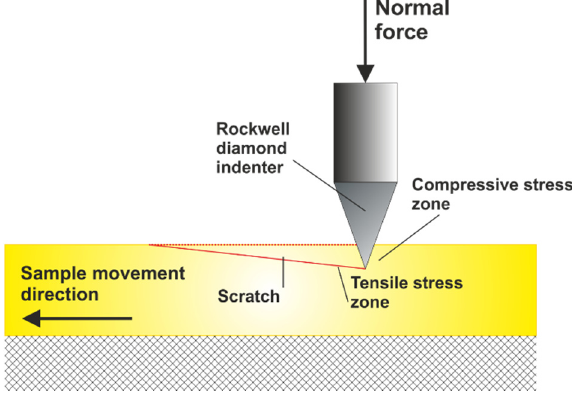
Figure 1. Schematic of the microscratch test.